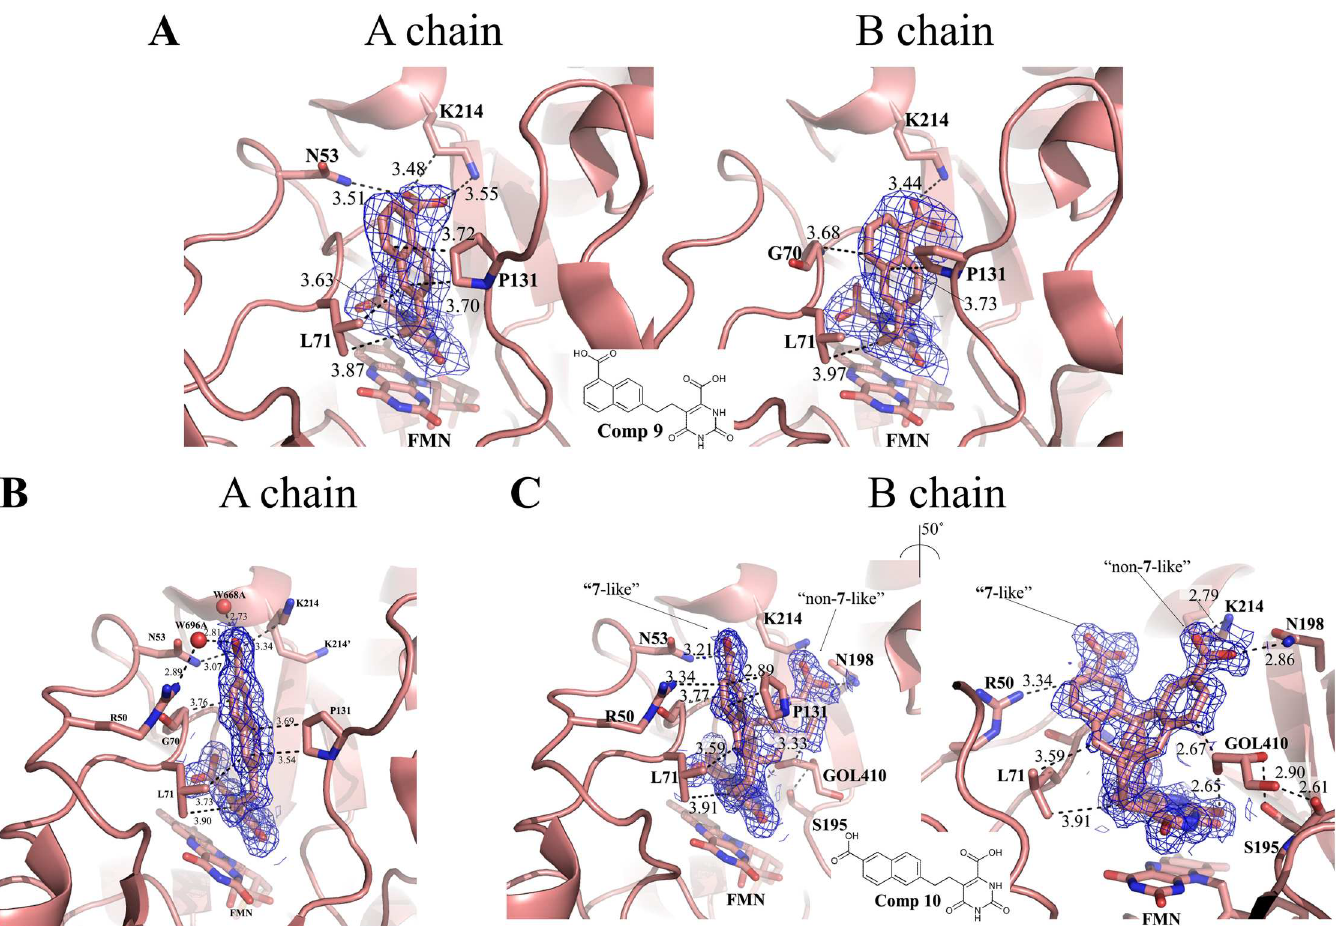
Fig 4. Binding modes of the top 2 TcDHODH inhibitors designed in this study. (A) Bindingmode of 9 to chains A (left) and B (right); (B) Bindingmode of 10 to the A chain; (C) Dual bindingmode of 10 into the B chain. Left and right panels emphasize the interactionsof 5-substituent groups from 7 -like and non- 7 -likebindingmodes, respectively. Key residueswithin a 4.0 Å distance to 5-subtituents 9 , 10 , and FMN are shown as stick. Dashedline represents hydrophobic or hydrogenbond interaction. Atoms of carbon, nitrogen, and oxygen are coloredin salmon, blue, and red, respectively.Electron density maps are shown as blue mesh and contoured at a 1 σ